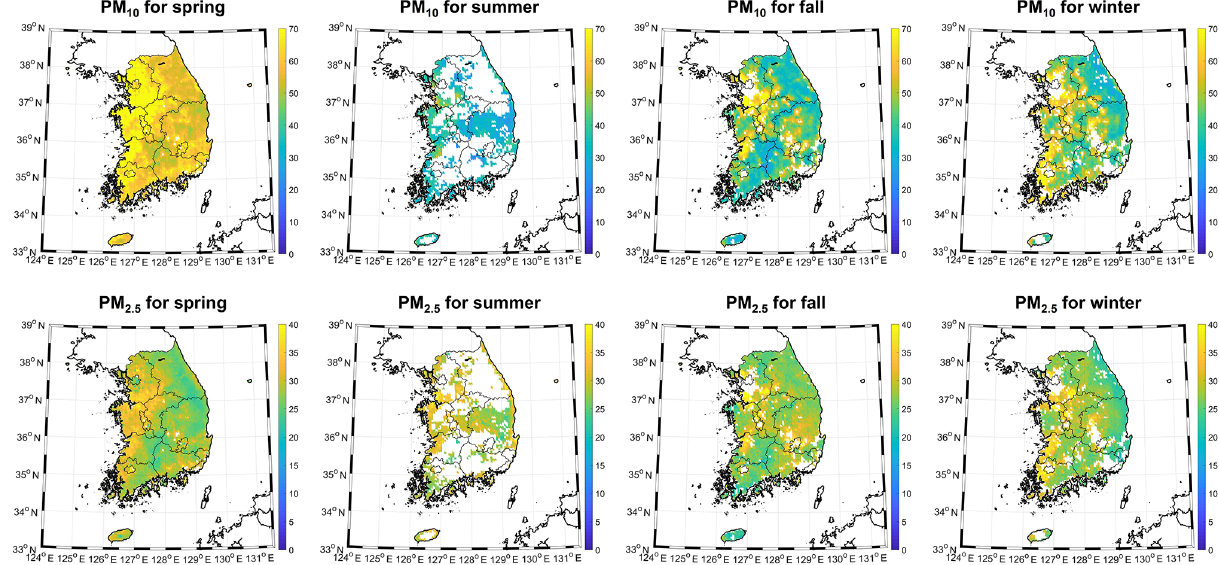
Figure 6. Spatial distributions of seasonal mean particulate matter concentrations (first row for PM 10 and second row for PM 2 . 5 ).